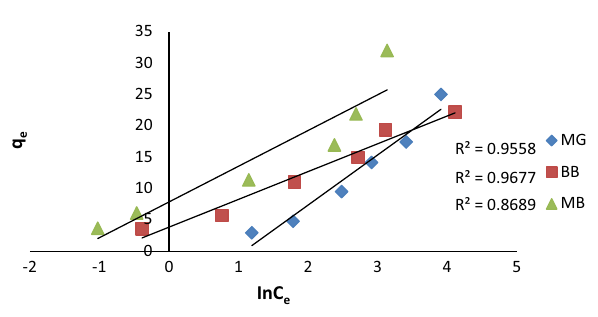
Fig. 8 Temkin adsorption isotherm on Zn(II) Fig. 9 Pseudo-first-order graph for adsorption of